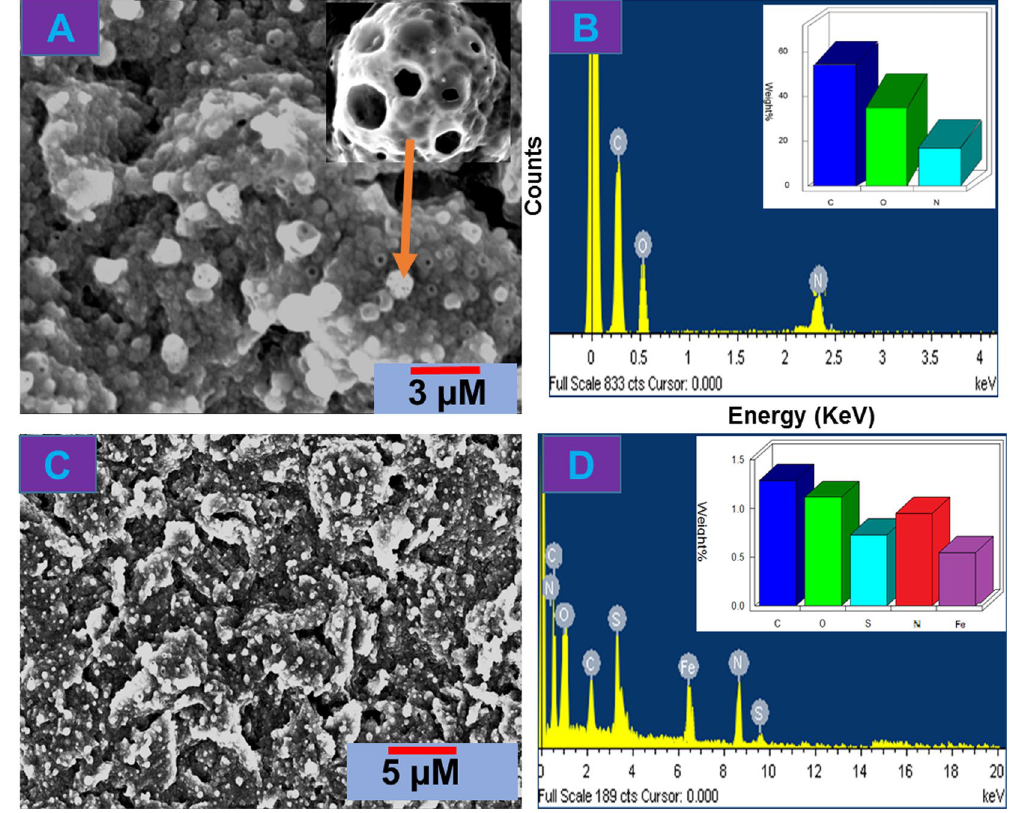
Figure 2. SEM images of MWCNTs@rGONRs/CHIT ( A ) and MWCNTs@rGONRs/CHIT/Mb ( C ). EDX spectra of MWCNTs@rGONRs/CHIT ( B ) and MWCNTs@rGONRs/CHIT/Mb ( D